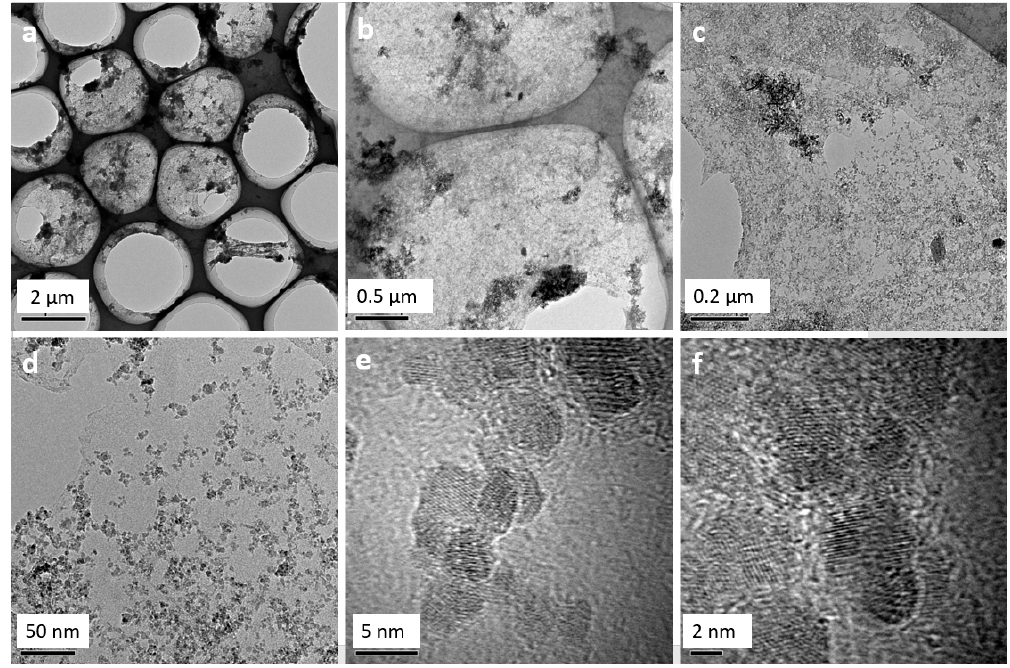
Figure 1. HRTEM image of Fe 3 O 4 @GO at different magnification; ( a ) 2100×, ( b ) 7000×, ( c ) 19,500×, ( d ) 71,000×, ( e ) 790,000×, ( f ) 1,050,000×.